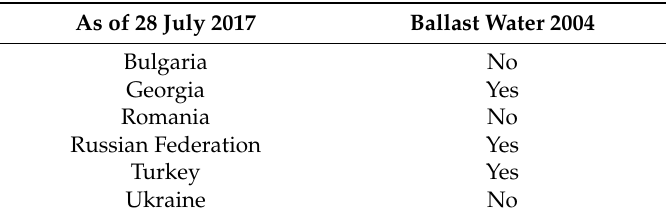
Table 1. Status of Black Sea countries for International Marine Organization (IMO) Ballast Water International